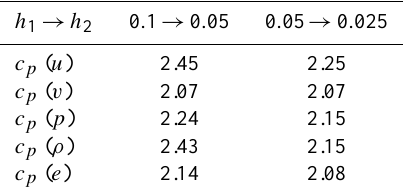
Table 2. Spatial order of convergence results for the method of manufactured solutions incompressible Navier-Stokes test case de- scribed in Sect. 4.1.2. The difference between the analytical and nu- merical solutions using a piecewise-quadratic velocity, (u,v) , and a piecewise-linear pressure, p , Galerkin discretisation are calculated in the L 2 norm. The ratio between these on two spatial mesh reso- lutions, h 1 and h 2 , are used to estimate the order of spatial conver- gence of the model for this problem. The expected order of conver- gence is observed for all variables. h 1 → h 2